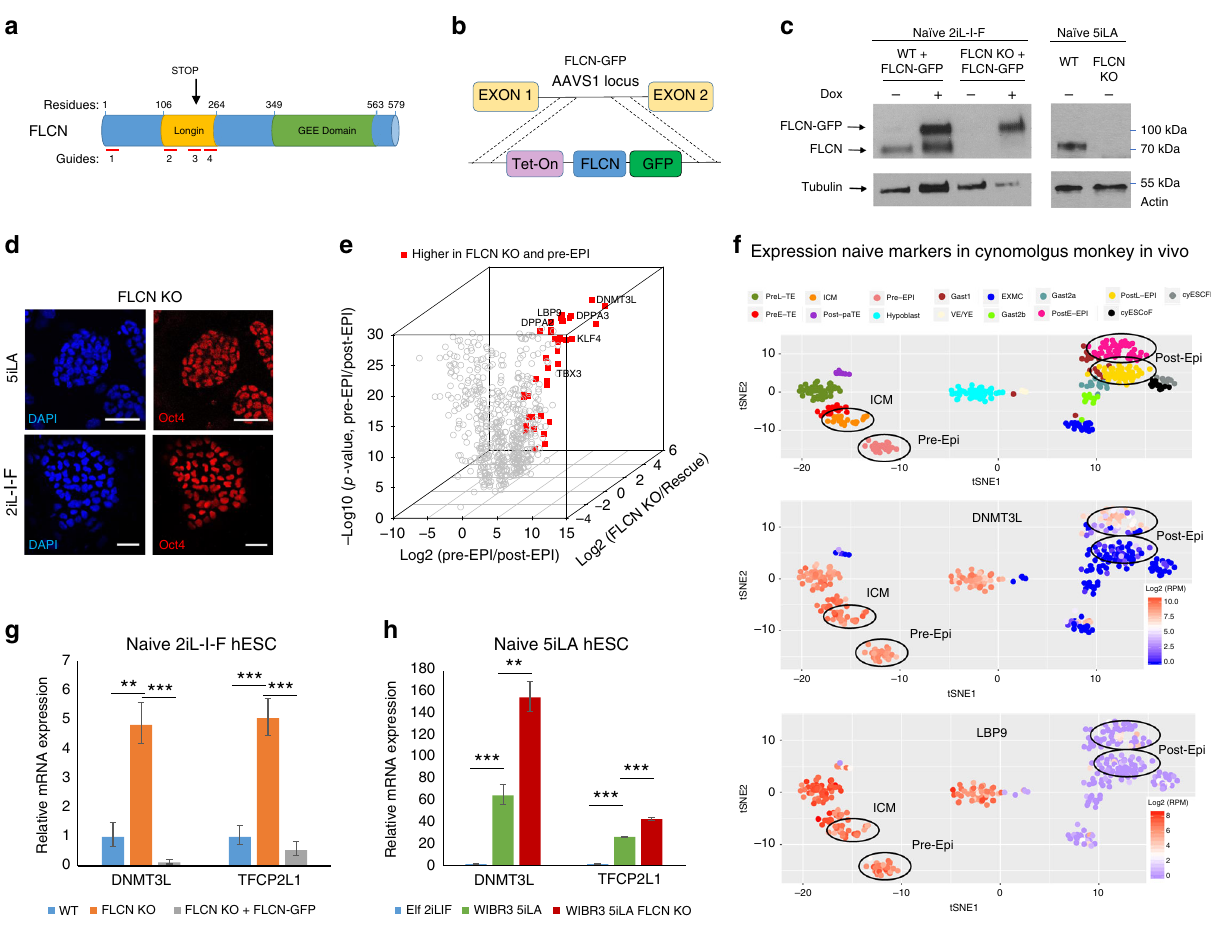
Fig. 2 FLCN KO hESC express naïve pluripotency markers. a Schematic representation of FLCN protein and location of CRISPR guide RNAs used. Sanger sequencing analysis of Elf1 2iL-I-F FLCN KO hESC reveals introduction of STOP codons in exons 3. b , c Generation of WIBR3 5iLA FLCN KO and Elf1 2iL-I-F FLCN KO line, and overexpression of FLCN-GFP fusion protein in wild type and FLCN KO background. d The pluripotency marker Oct4 is expressed in FLCN KO 2iL-I-F and 5iLA hESC. Scale bars represent 50 μ m. e Expression pattern of genes up-regulated by FLCN KO compared to genes up-regulated in monkey pre- vs. post-implantation stage. Red: genes up-regulated in FLCN KO and pre-implantation, known ground state pluripotency markers are labeled. f tSNE analysis of naïve markers DNMT3L, TFCP2L1, and ESRRB in in vivo blastocysts from non-human primate, cynomolgus monkey ( Macaca fascicularis 33 ). g , h RT-qPCR analysis of naïve markers DNMT3L and TFCP2L1 in naïve 2iL-I-F wild type (WT), FLCN KO, and rescue line (FLCN KO + OE FLCN-GFP) ( g ) and in naïve 5iLA WT and FLCN KO ( h ). S.e.m.; ** p < 0.005, *** p < 0.001; two-tailed t -test, n = 3 – 10 biological hESC are signi fi cantly enriched for monkey pre-implantation marker genes (hypergeometric test p -value 1.27 × 10 − 41 ) while genes up-regulated in 7-day TeSR in wild type are signi fi cantly enriched for monkey post-implantation marker genes (hyper- geometric test p -value 5.54 × 10 − 49 ) (Fig. 3c; Supplementary Data 4B, C). We validated these observations by RT-qPCR and western blot (Fig. 3d – g). When induced to exit the naïve state by omitting the signaling pathway inhibitors and activating FGF pathway using TeSR medium, the FLCN KO line failed to exit (naïve marker DNMT3L still expressed, Fig. 3d; primed markers IDO1, LDHA, and HIF1 α not upregulated, Fig. 3e, f; Supplementary Fig. 3A; ref. 1 ). Overexpression of